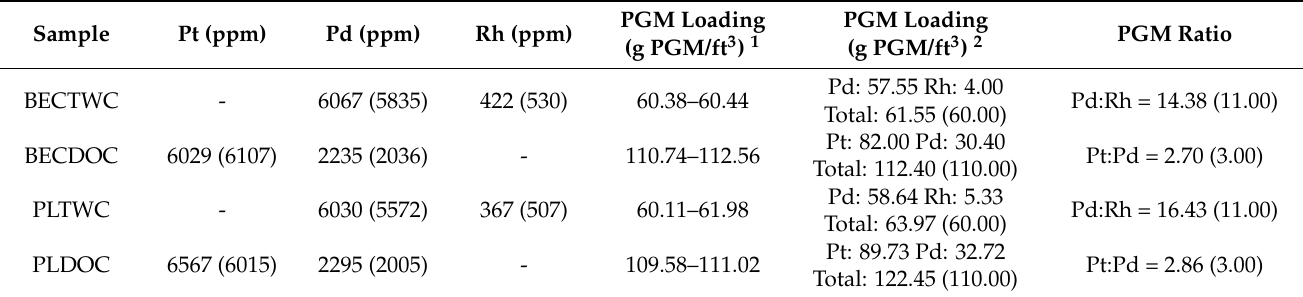
Table 2. XRF Analysis of sample powders (monolithic carrots). The theoretical values are presented in parentheses. Sample